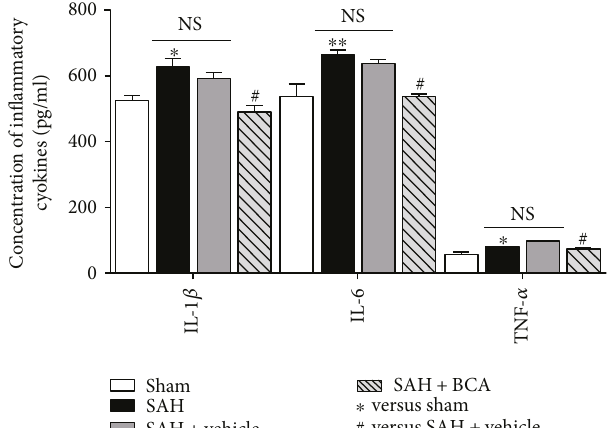
Figure 7: The e ff ects of BCA on the concentrations of in fl ammatory cytokines at 24 hours post SAH ( n = 6 , each group; ∗ P < 0 05 and ∗∗ P < 0 01 versus sham; # P < 0 05 versus SAH+vehicle; NS P > 0 05 ). [16]. Data from the modi fi ed water maze test were as fol- lows: escape latencies (s, time data and average data) and swimming distance (cm, distance data and average data) in every test trail for the rats to get on the hidden platform in the water maze [24].